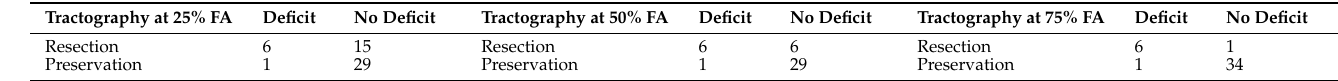
Table 3. Contingency tables showing the predictive value of resection vs. preservation of WMTs at difference FA thresholds.